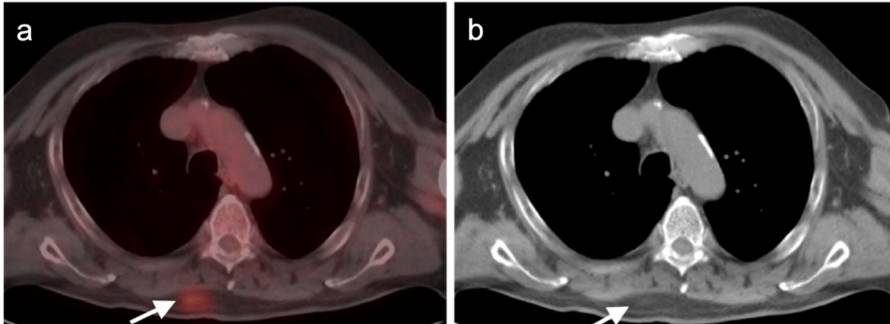
Figure 21. Hibernoma (benign brown fat lipoma). ( a ) Axial FDG PET-CT image of the chest shows an incidental hypermetabolic (SUVmax 5.3) fat-attenuating region in the right posterior paraspinous region as a small, mobile, slightly firm nodule (white arrow). ( b ) A concurrent axial CT image of the chest shows the fat to be minimally high in attenuation at this site (white arrow). Biopsy showed adipocytes and brown fat cells with hypervascularity. There was no evidence of malignancy. The appearance would be indistinguishable from low-grade liposarcoma on FDG PET-CT imaging.